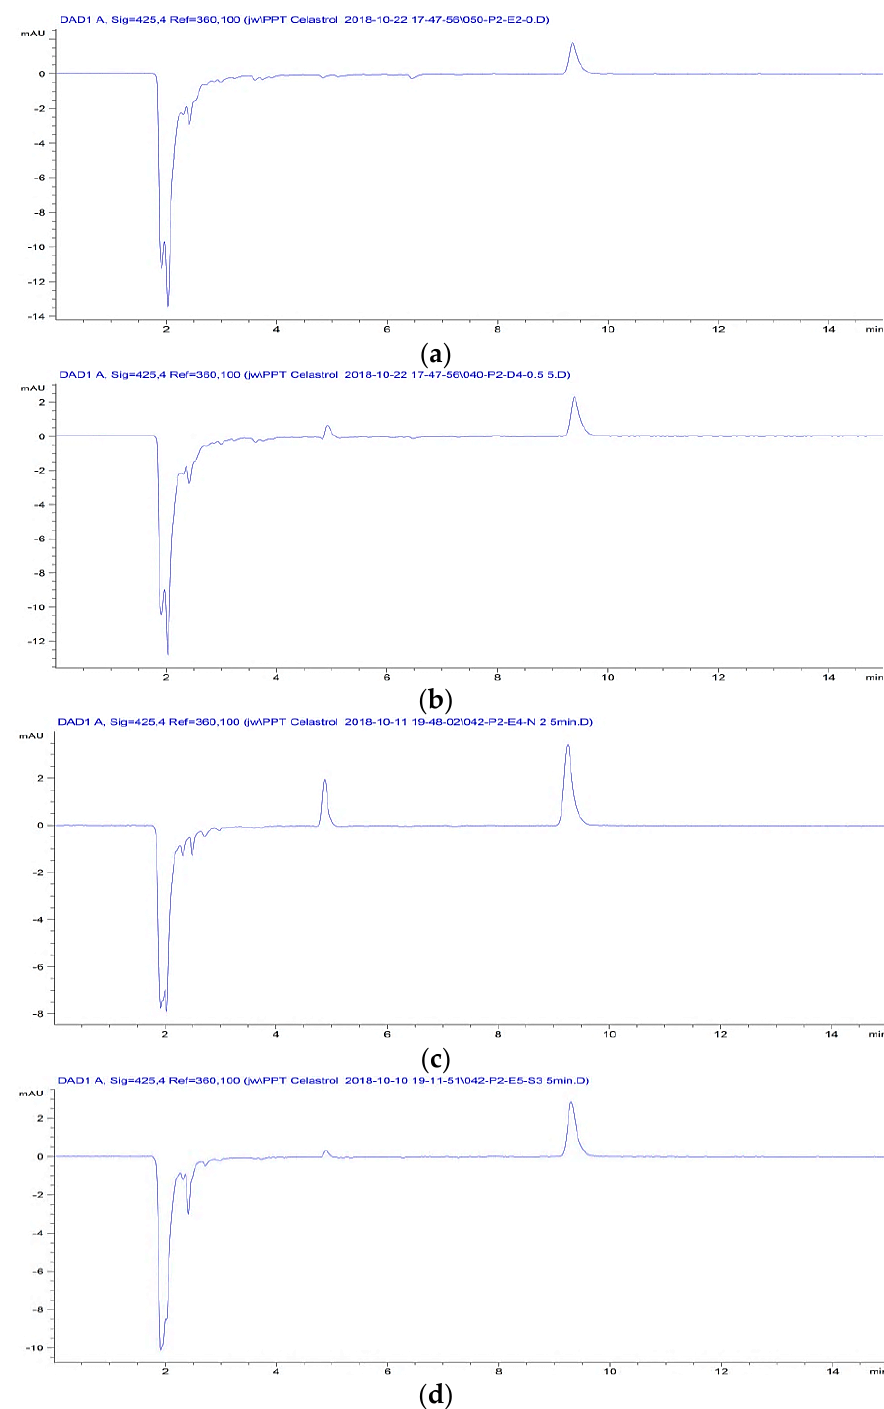
Figure 3. Chromatograms of processed samples of (a) Blank plasma spiked IS (2 µg/mL) ( b ) Rat plasma spiked with CL (0.5 µg/mL) and IS (2 µg/mL) ( c ) Rat plasma at 5 min after IV dosing of CL-SFNP (1 mg/kg) d. Rat plasma at 5 min after IV dosing of CL-solution (1 mg/kg).